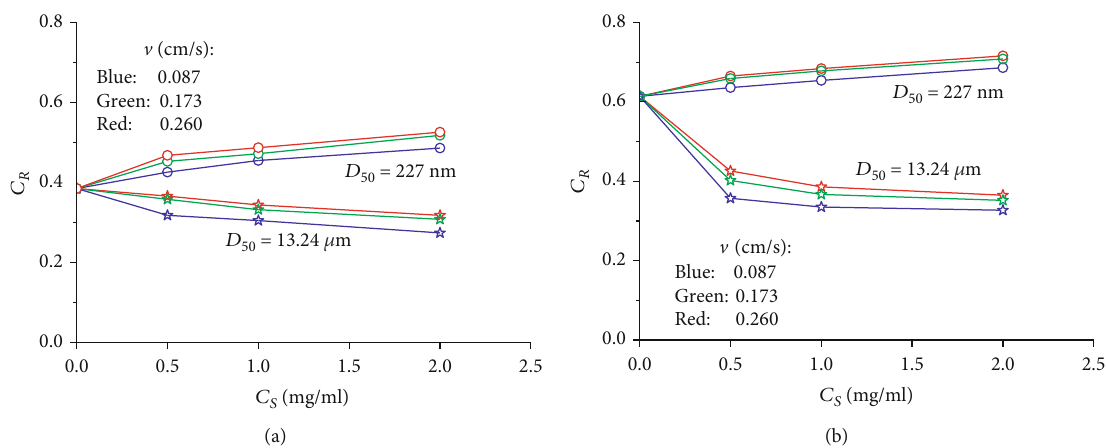
C M = 100 ng/ml and (b) M = 400 ng/ml .